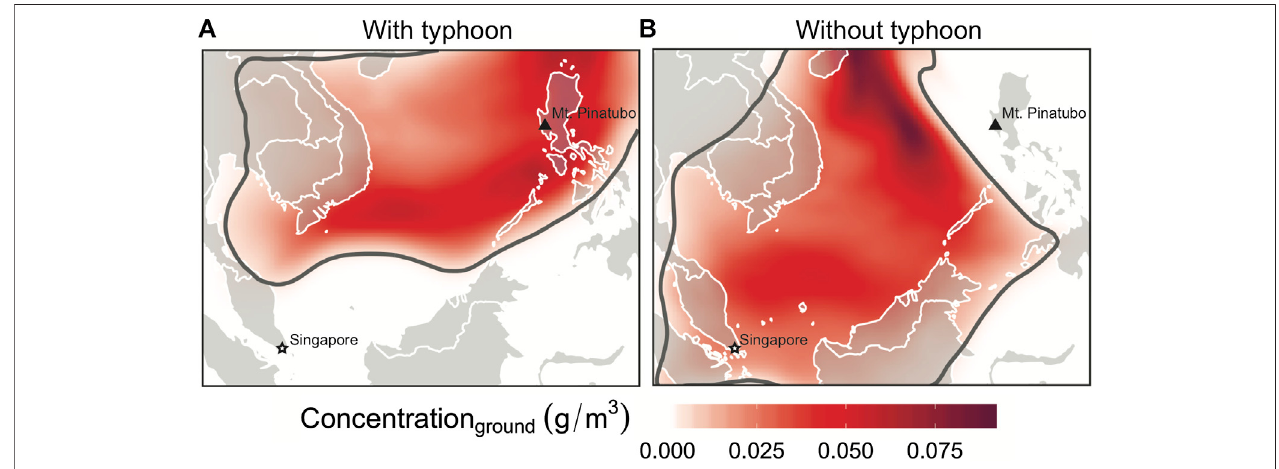
FIGURE 6 | Ash distribution at ground level at the end of each scenario (A) with the coinciding typhoon and (B) without the coinciding typhoon. The base layer is a map of Southeast Asia, with land shown in gray, and Singapore ’ s location is marked with a black star. The dark gray line identi fi es the boundary of modern-day no- fl y concentrations of 0.004 g per cubic meter as de fi ned in Zehner (2012).